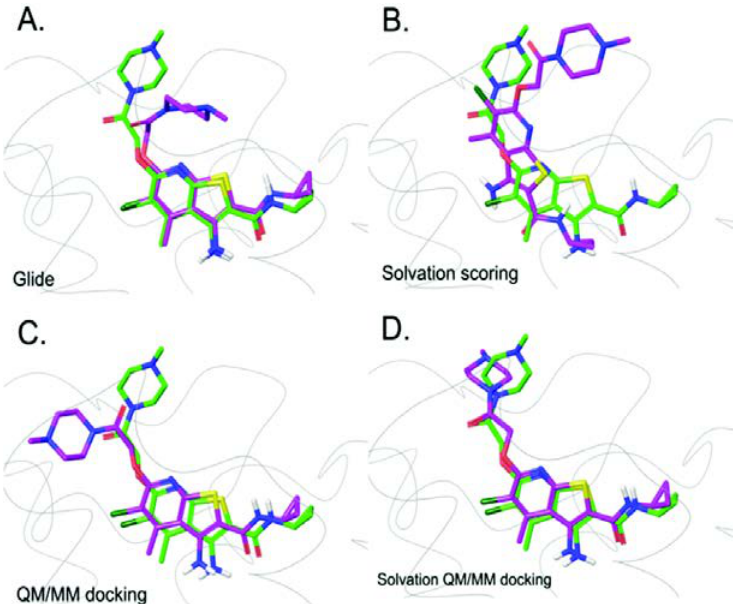
Figure 3. Prediction of LY2119620 binding modes using the four docking methods (green – crystal pose, purple – predicted pose). ( A ) Glide docking result. ( B ) Solvation scoring result. ( C ) QM/MM docking result. ( D ) Solvation QM/MM docking result. Heteroatoms are shown in yellow (S), red (O), blue (N), and dark green (Cl). Reproduced from Reference 43 with permission from the PCCP Owner Societies.